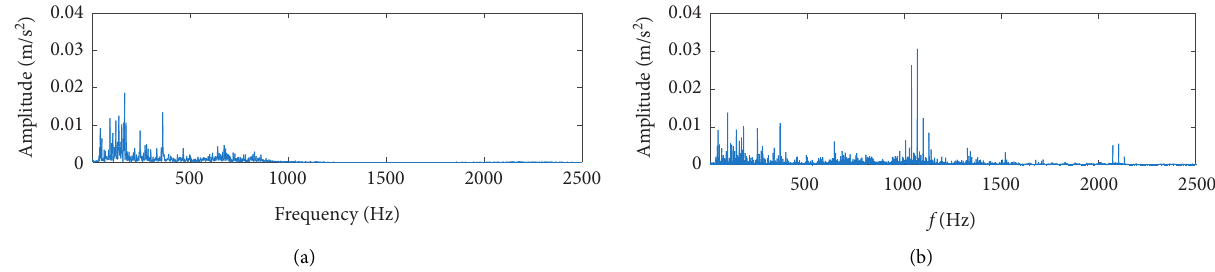
Figure 7: The spectrum of vibration signal (a) after wavelet denoising and (b) after SCICA-wavelet denoising.